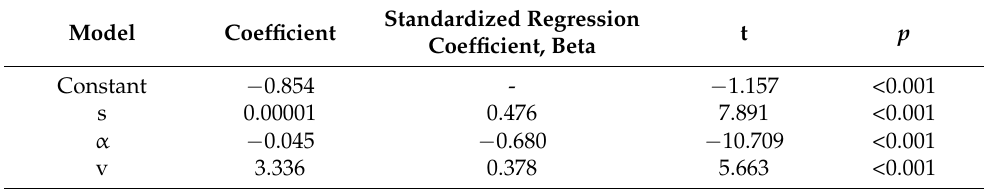
Table 18. Coefficients of the regression model for slurry pot